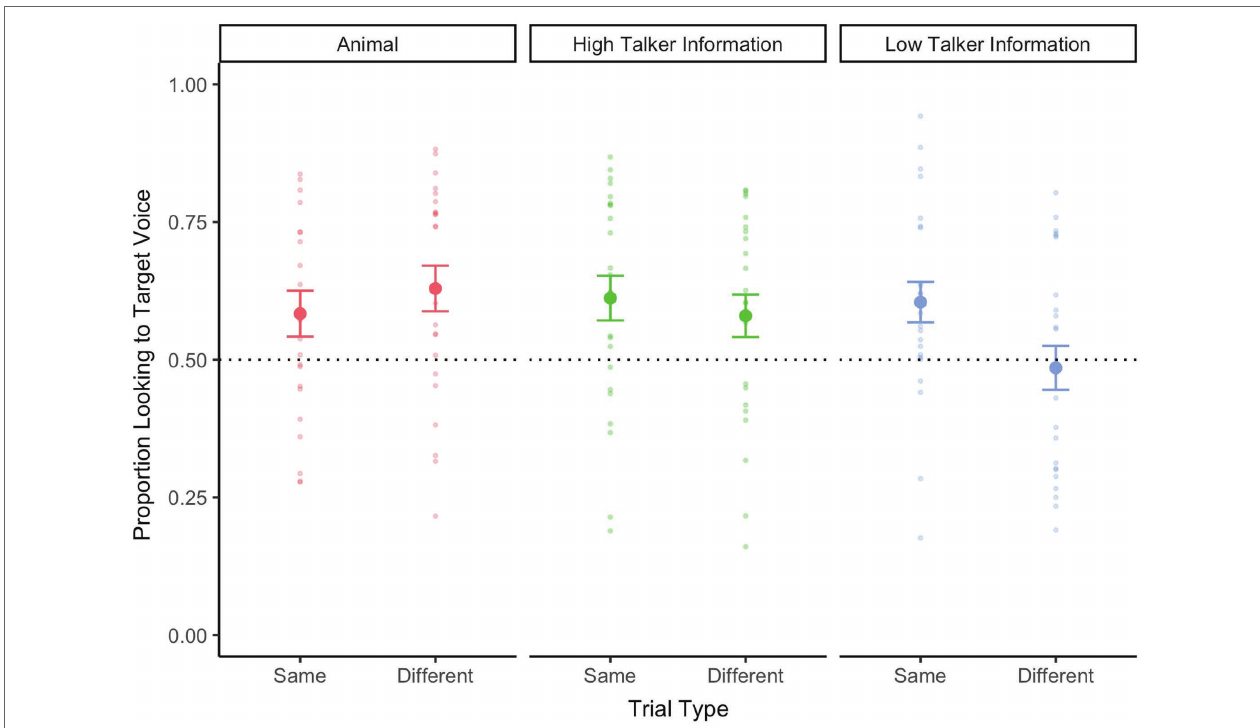
FIGURE 3 | Twenty-four-month-old infants’ looking data during the critical WoA in the test phase, separated by trial type (s ame speaker vs. different speaker ) and talker information (high talker vs. low talker). The looking data for animal trials are also represented on this graph. A value above 0.5 represents proportionally longer looking time to the target voice. The dotted line at 0.5 refers to equal proportion looking to both faces on the screen. Errors bars represent standard